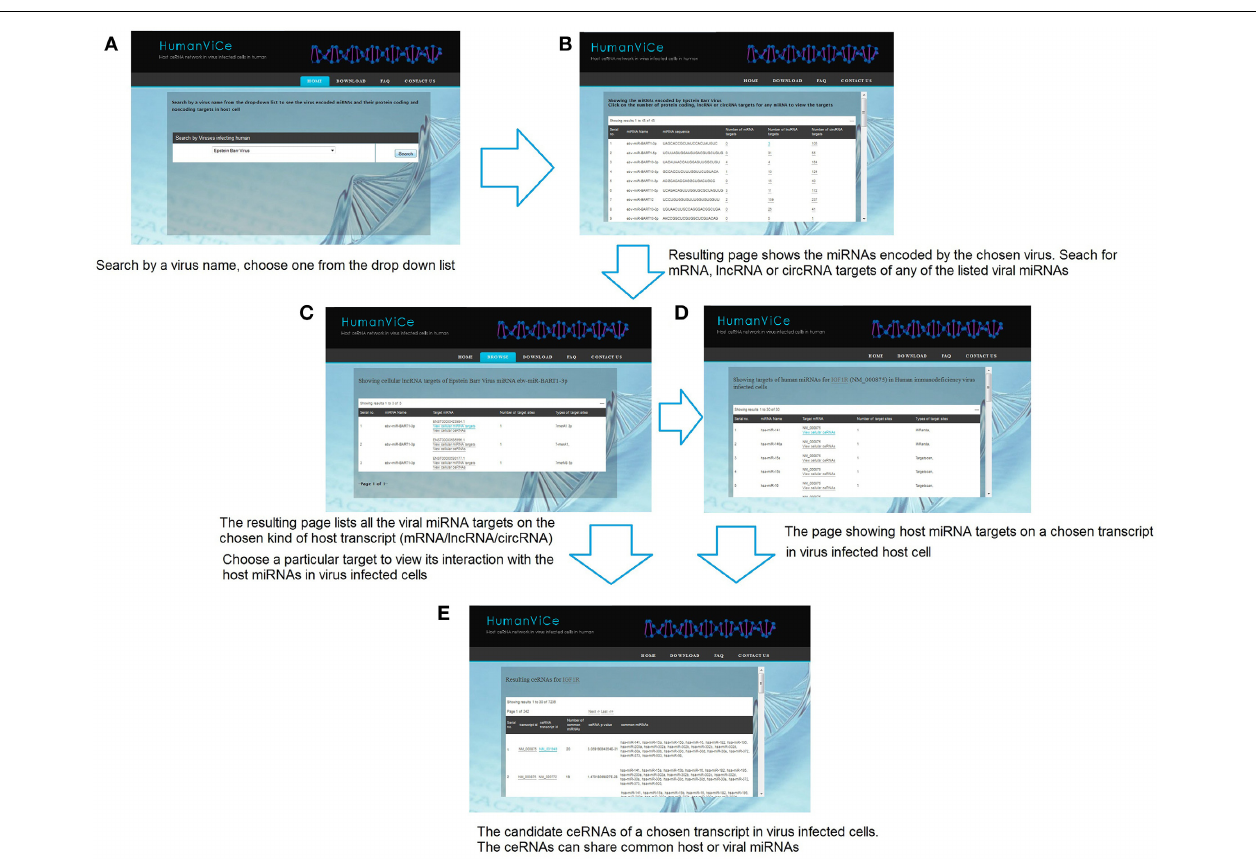
FIGURE 5 | The navigation of HumanViCe is depicted. (A) Users can search by a virus name. (B) Resulting page shows the list of miRNAs encoded by the chosen virus along with the number of mRNA, lncRNA and circRNA targets of each of the viral miRNAs. Searching for targets of a particular transcript type (mRNA, lncRNA or circRNA) for a particular viral miRNA from the list results in (C) a page listing all the targets of the chosen